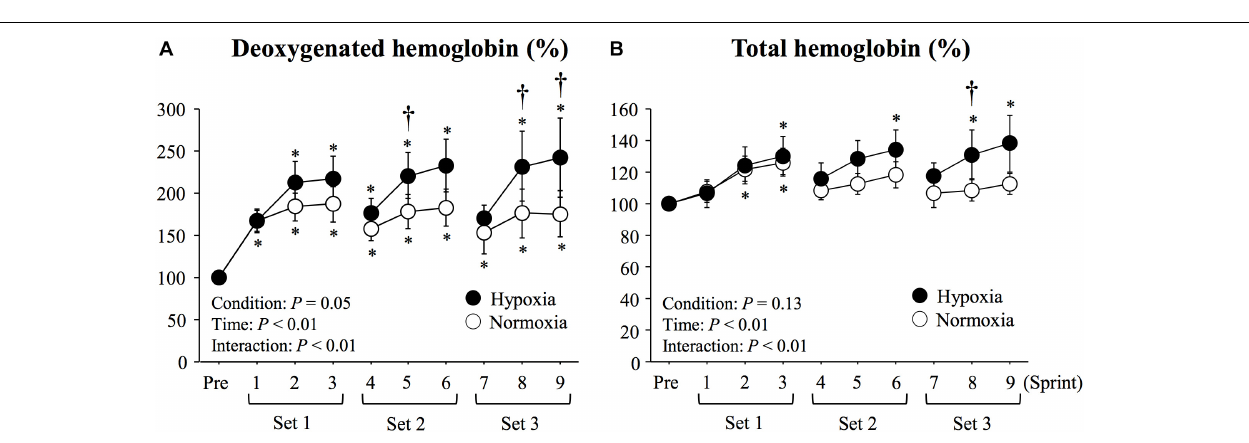
FIGURE 3 | Changes in triceps brachii muscle deoxygenated hemoglobin (A) and total hemoglobin (B) during repeated double-poling exercise. Values are means ± SE. ∗ P < 0.05 vs. Pre. † P < 0.05 HYP vs.